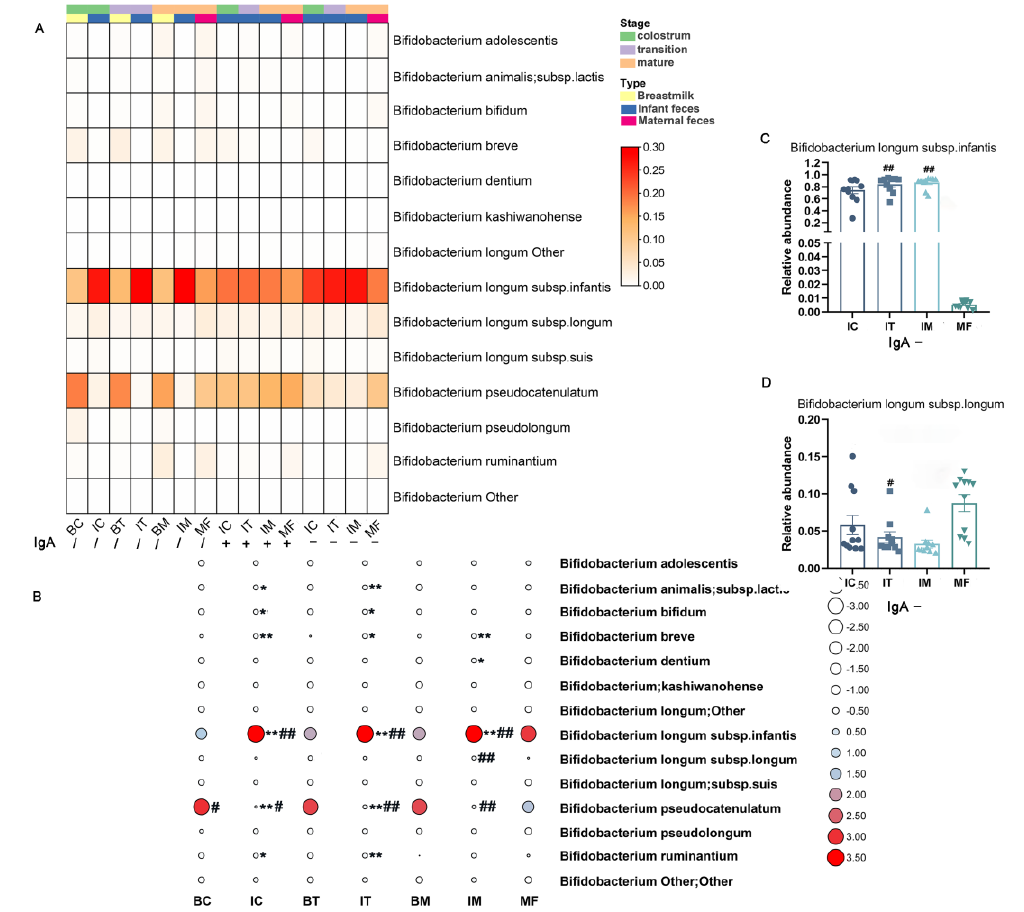
Figure 6. Distribution of Bifidobacterium in total sIgA-coated and -uncoated Bifidobacterium in HBM, infant feces, and maternal feces. ( A ) Heatmap of the composition of the total sIgA-coated and -uncoated Bifidobacterium in HBM, infant feces, and maternal feces. Genera of relative abundances > 0.01% and calculated with log10 are shown. The darker color corresponds to higher relative abundance of the genus. ( B ) The significantly different total Bifidobacterium between different samples. The relative abundance of Bifidobacterium is shown in column normal normalized. The greater the relative quantity of Bifidobacterium , the deeper the red hue and the larger the circle. Greater abundance is indicated by larger white circles. *, p < 0.05; **, p < 0.01; three stages of infant feces compared to corresponding BC, BT, and BM. ( C , D ) Relative abundances of sIgA-uncoated Bifidobacterium in infant and maternal fecal samples. #, p < 0.05; ##, p < 0.01; three stages of HBM and infant feces compared to maternal feces. BC, BT, BM, IC, IT, and IM stand for colostrum, transitional milk, mature milk, and infant feces corresponding to HBM stages. / means unsorted bacteria; IgA − means IgA-uncoated bacteria.